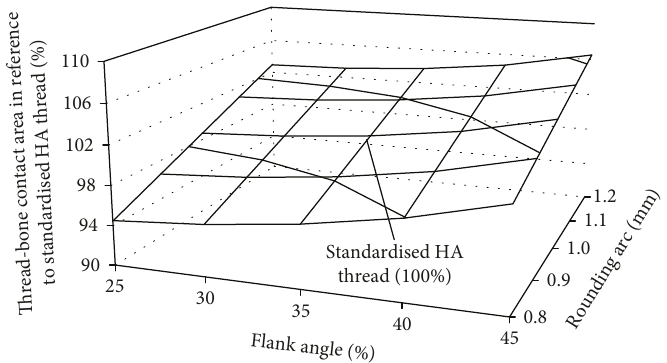
Figure 9: The in fl uence of fl ank angle and rounding arc on the thread-bone contact